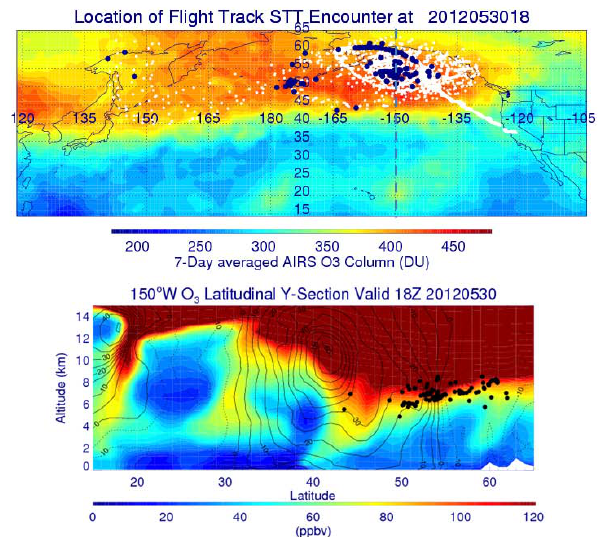
Fig. 11. Map of 7-day averaged (30 May–5 June 2012) AIRS total column O 3 (DU, top) with the STT back trajectory history (white) and origin (blue) and RAQMS 150 ◦ W O 3 (ppbv) and zonal wind (ms − 1 ) cross section (bottom) with origin of STT encounter (blue dots) at 18:00UTC on 30 May 2012 for analysis of AJAX flight on 5 June